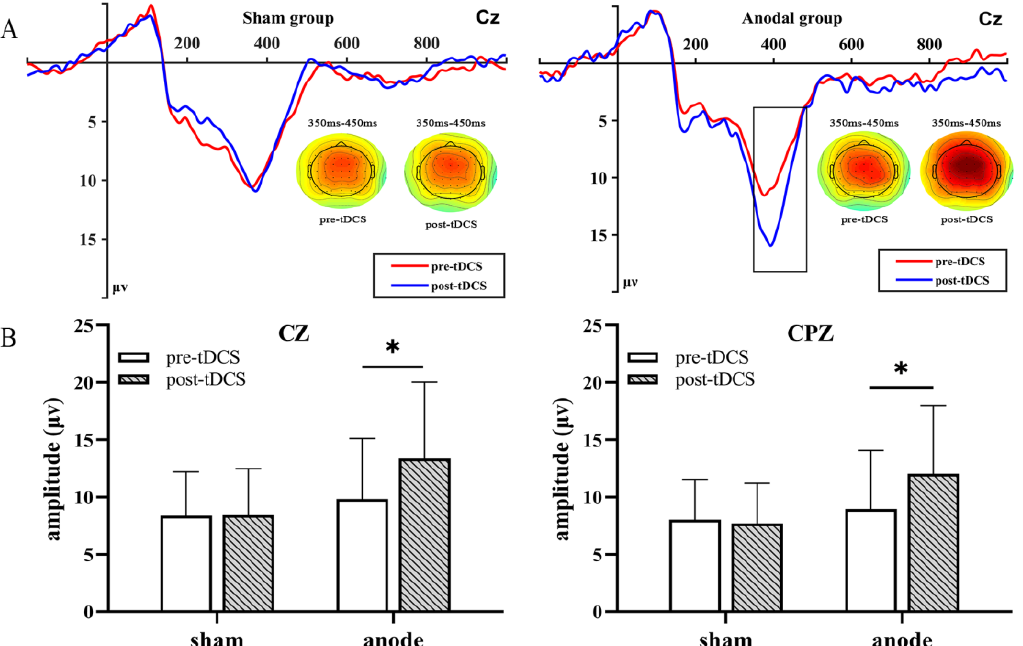
Figure 4. The results obtained from the CZ electrode are shown in ( A ). A significant difference in P300 was seen before and after treatment under high-risk conditions based on a paired t test. The black boxes define the time windows of interest where the amplitude increases significantly. In addition, ( B ) shows the P300 amplitude increased bar graph at two locations [bars indicate the standard error of the mean. * p <0.05] . Table 2. Planned 2 × 2 repeated measure ANOVA on P300 amplitude over time (pre-tDCS, post- tDCS) .